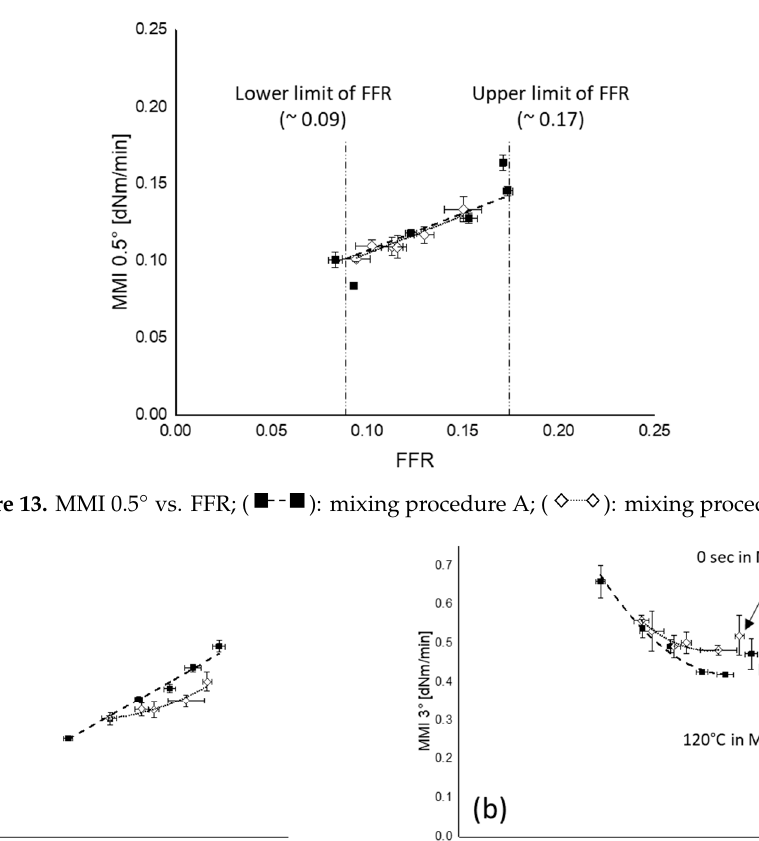
Figure 14. MMI vs. CR: ( a ) MMI 0.5° and ( b ) MMI 3°; (